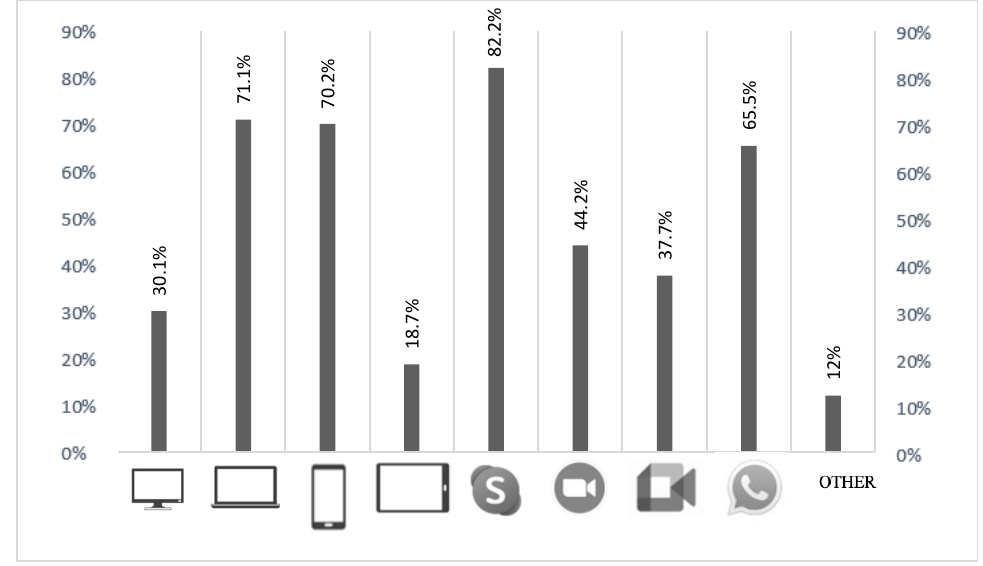
Figure 1. Hardware and software implemented to deliver online intervention during the pandemic . Participants’ mean levels of satisfaction with hardware (M = 4.17; SD = 0.783) and